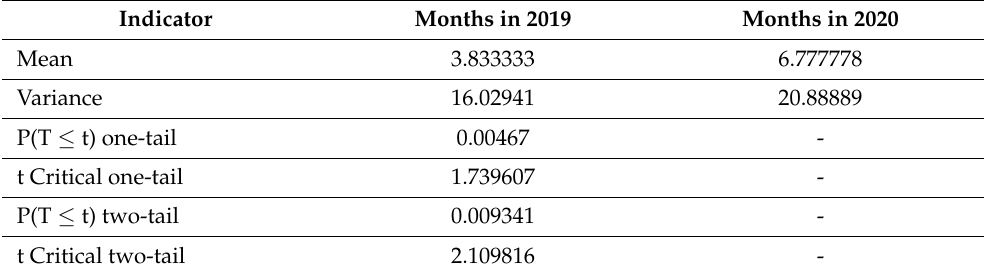
Table 2. Differences between the numbers of months worked in 2019 and in 2020.